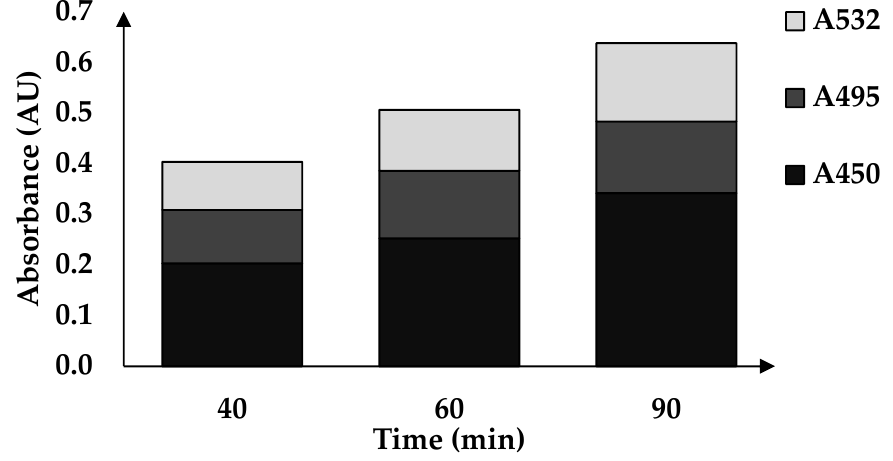
Figure 1. The absorbances obtained at the three incubation times.